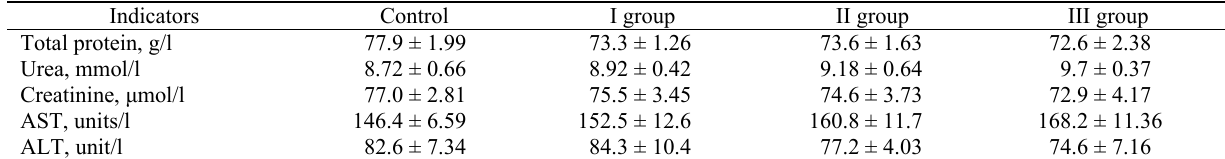
Biochemical indicators of the blood of white rats for the study of toxicity by the classical method (M ± m, n = 5)